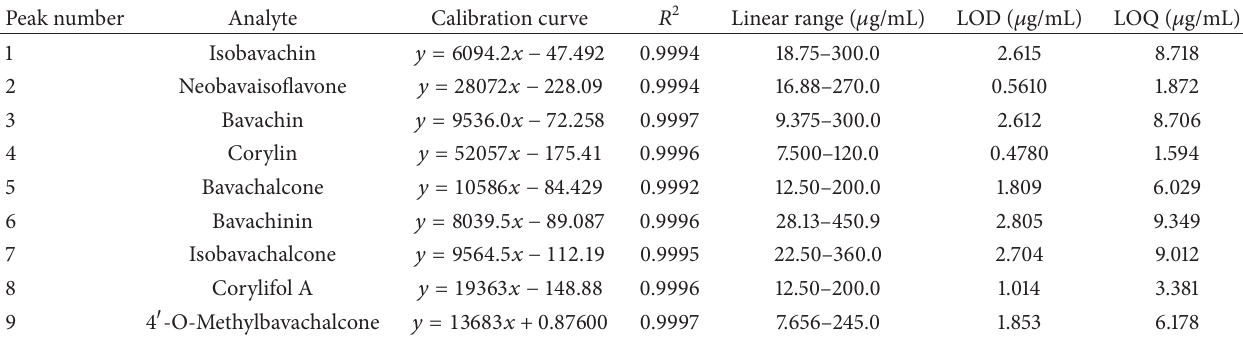
Table 2: Calibration curves for the 9 compounds determined.